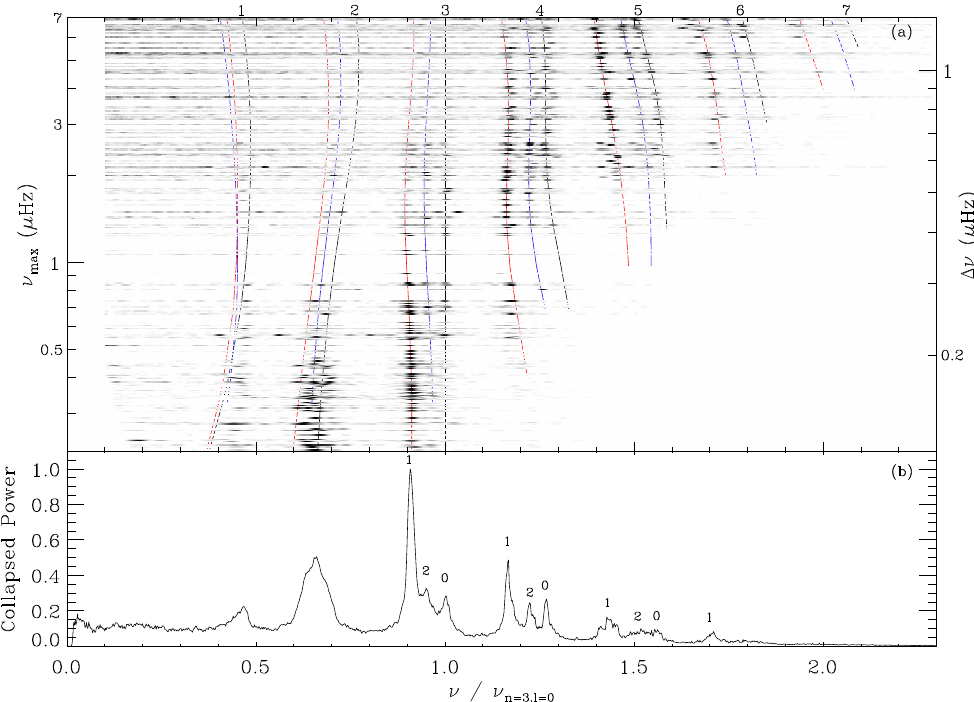
Fig. 1: (a) Observed power spectra of 195 Kepler stars. The models are plotted beneath the data with l = 0 in black, l = 1 in red, and l = 2 in blue. The radial order is indicated above. (b) Vertically collapsed version of (a) with the numbers denoting the angular